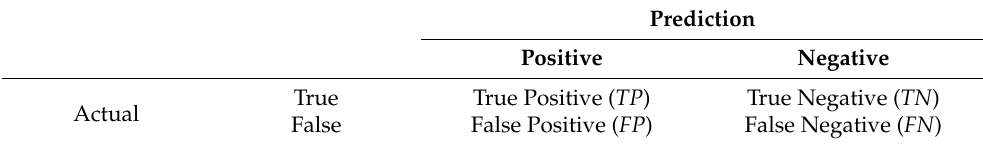
Table 3. Confusion matrix.